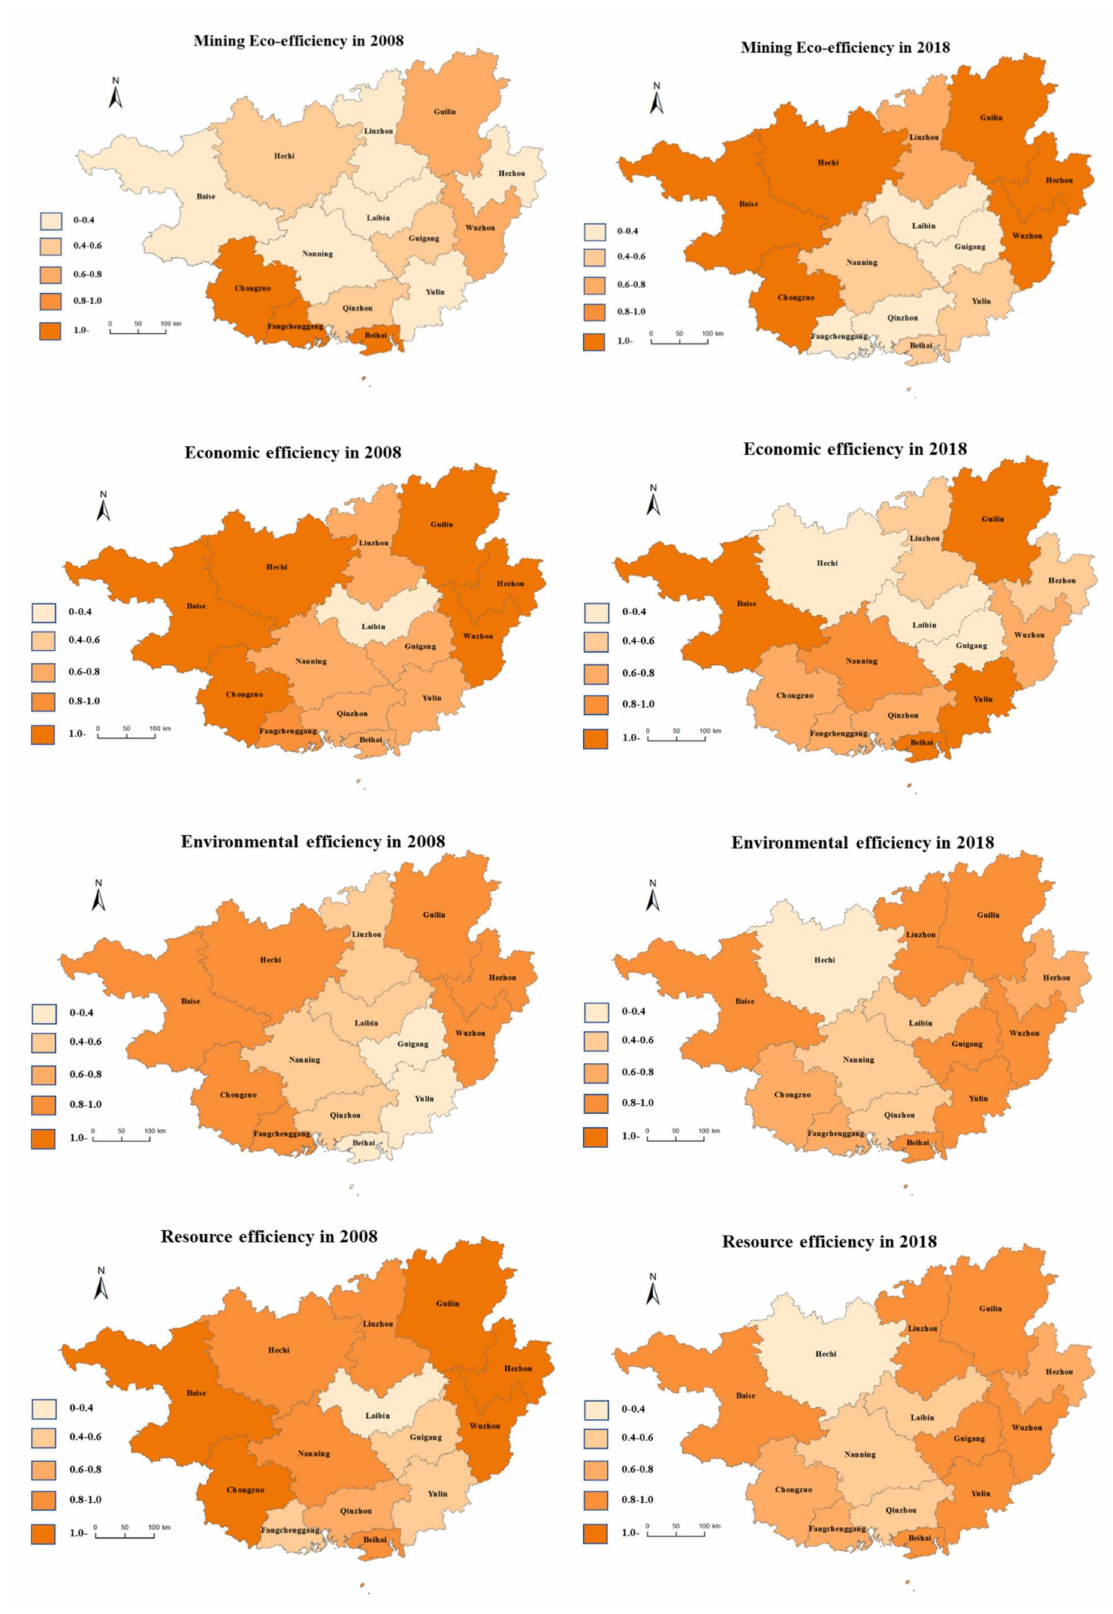
Figure 4. Regional distribution of mining eco-efficiency, economic efficiency, environmental efficiency, and resource efficiency in 2008 and